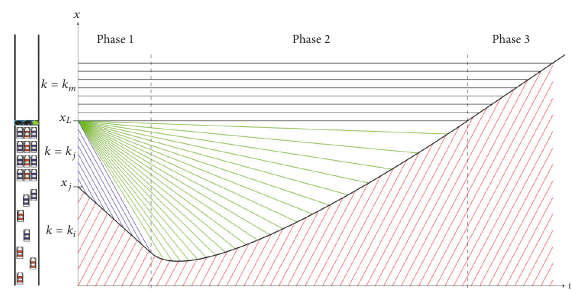
Figure 1: Characteristic diagram for traffic moving at a traffic